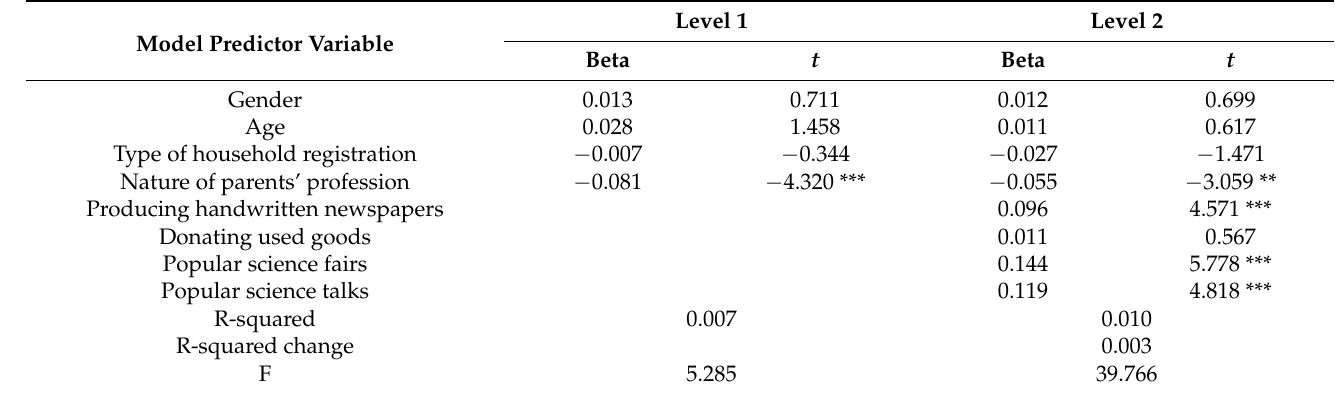
Table A3. Regression analysis of the effects of four types of climate change knowledge on supportive attitudes toward carbon neutrality education.